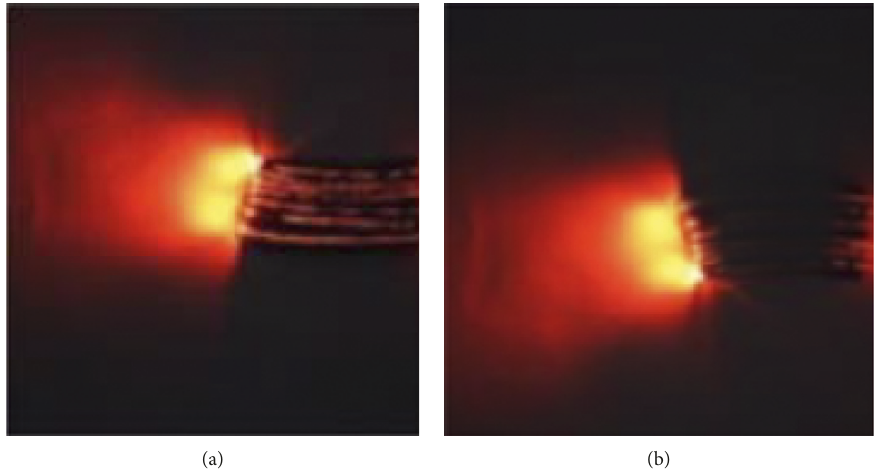
Figure 18: Example of a 2 by 2 twill weave fabric with one-sided cladding-removal POFs. (a) Front. (b) Back.